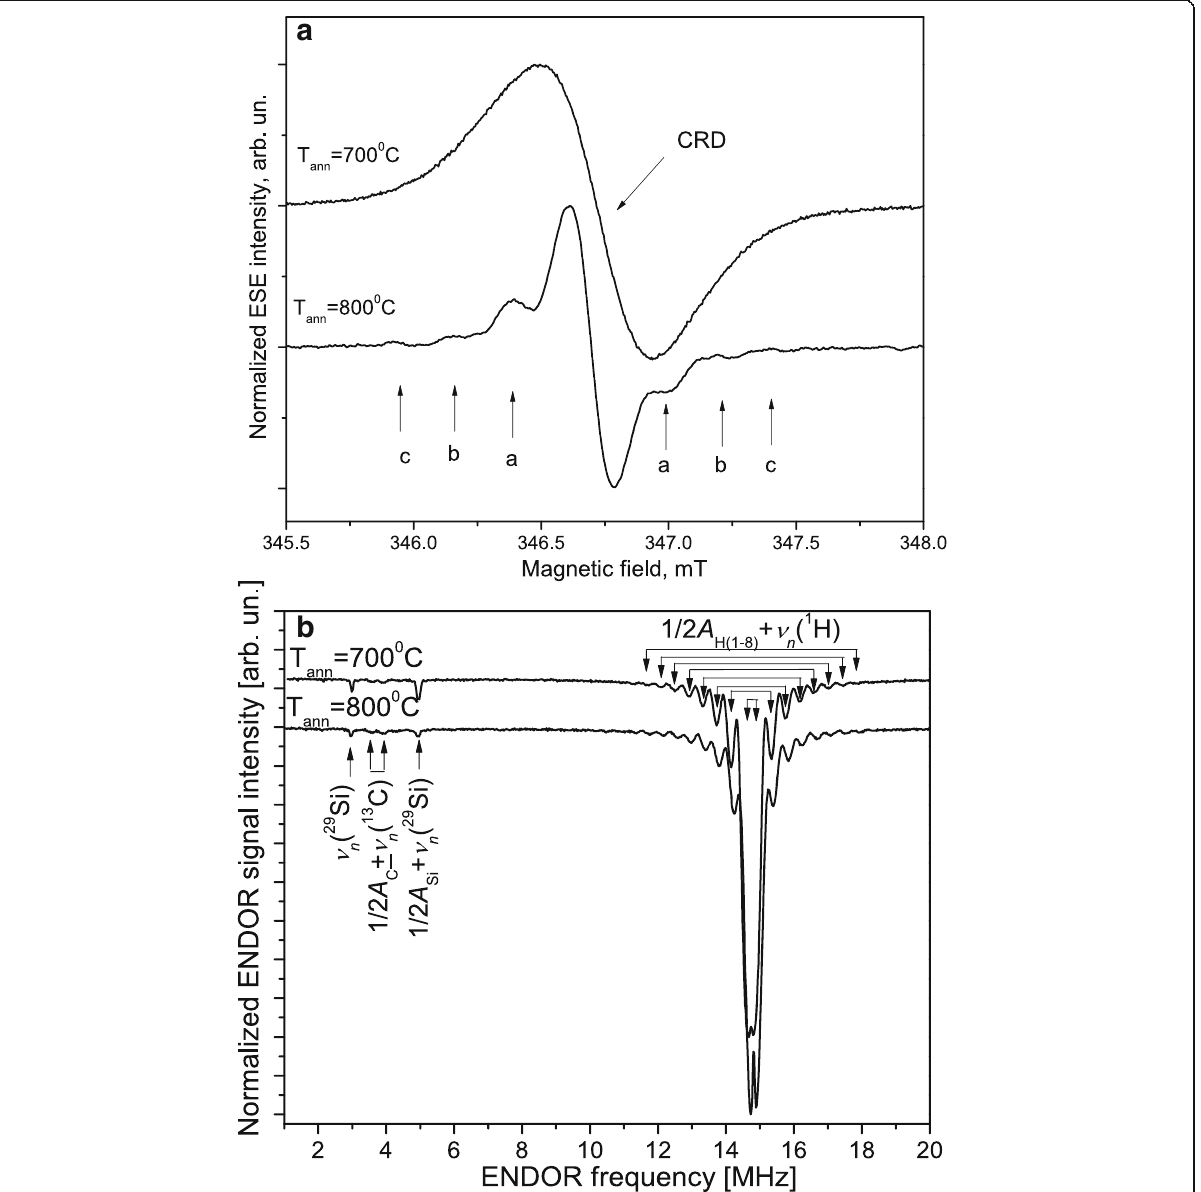
Fig. 6 The first derivative of X-band ED EPR spectra measured in SiO 2 :C samples annealed at 700 °C ( upper traces ) and 800 °C ( lower traces ) ( a ). The X-band Mims pulsed ENDOR spectra measured in SiO 2 :C samples annealed at 700 °C ( upper trace ) and 800 °C ( lower trace ) when the magnetic field was set to the CRR field position. ( b ). T =10